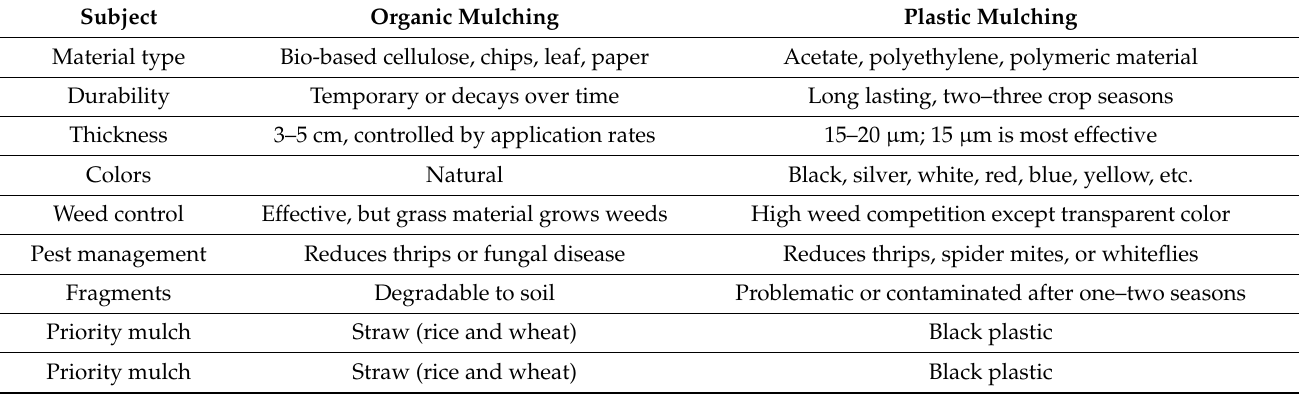
Table 2. Explained comparison of different organic and inorganic